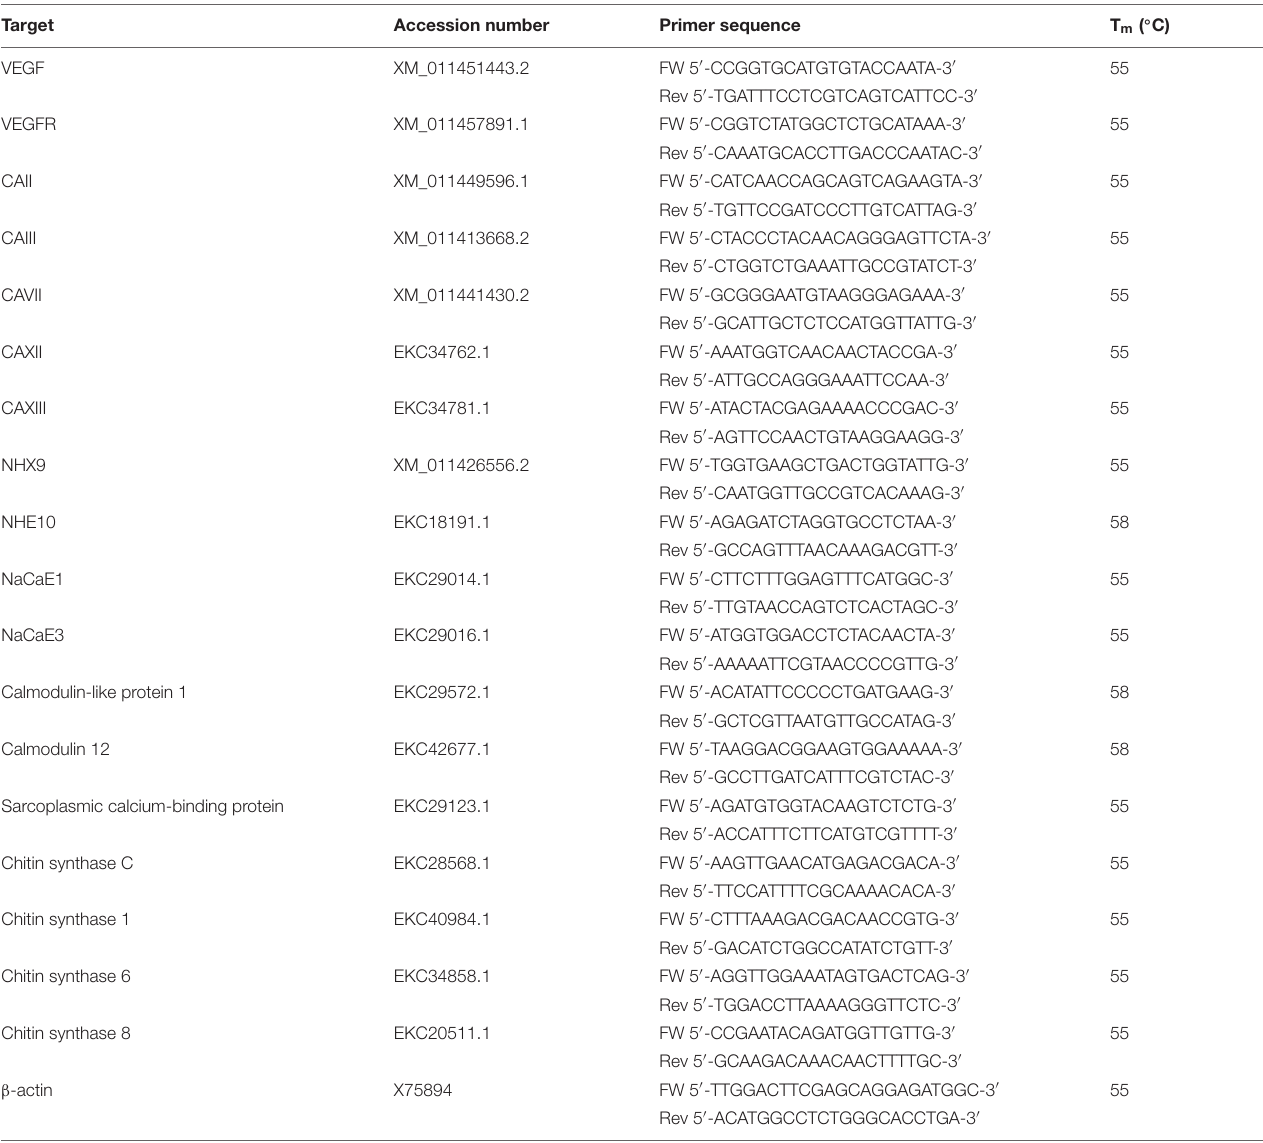
TABLE 1 | Primers used to amplify the target VEGF regulated biomineralization genes of C. gigas